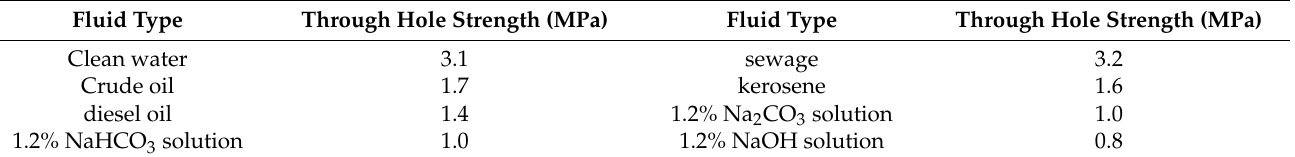
Table 9. Comparison of via strength of particles after immersion in various